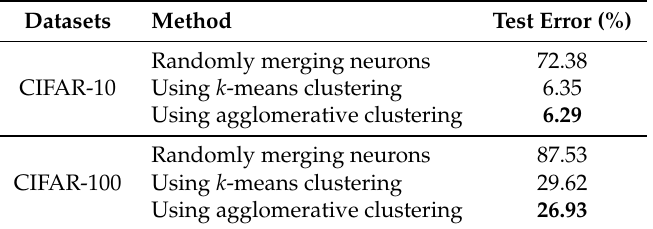
Table 5. Comparison results between neuron agglomerative clustering (NAC) and network compression by randomly merging neurons and using k -means clustering on the CIFAR-10 and CIFAR-100 datasets.